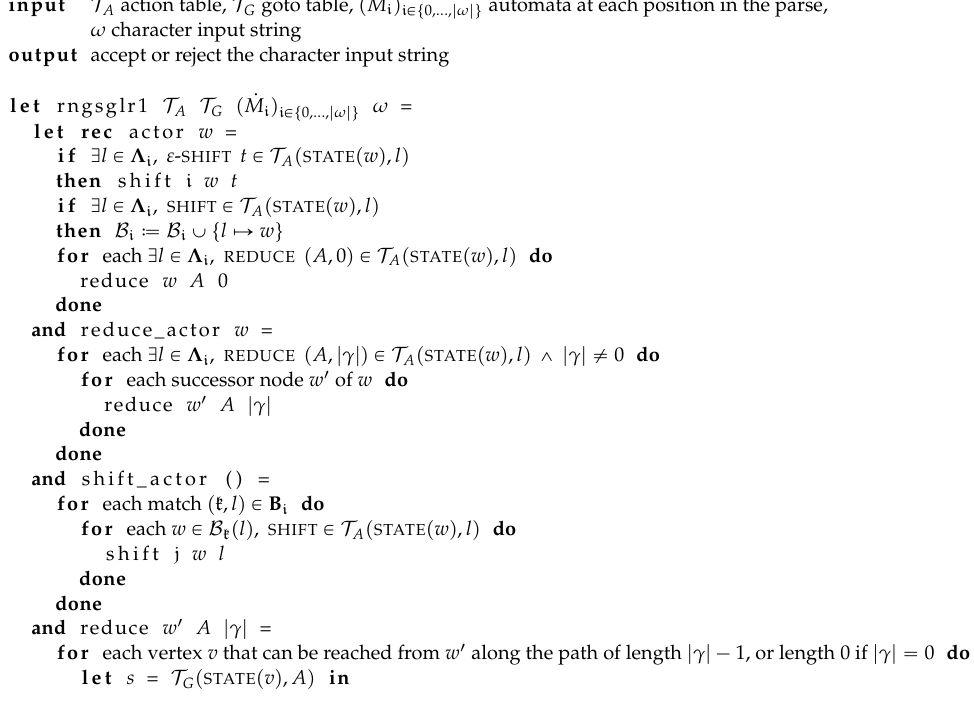
Algorithm 1. RNGSGLR(0,1] recognizer for character-level